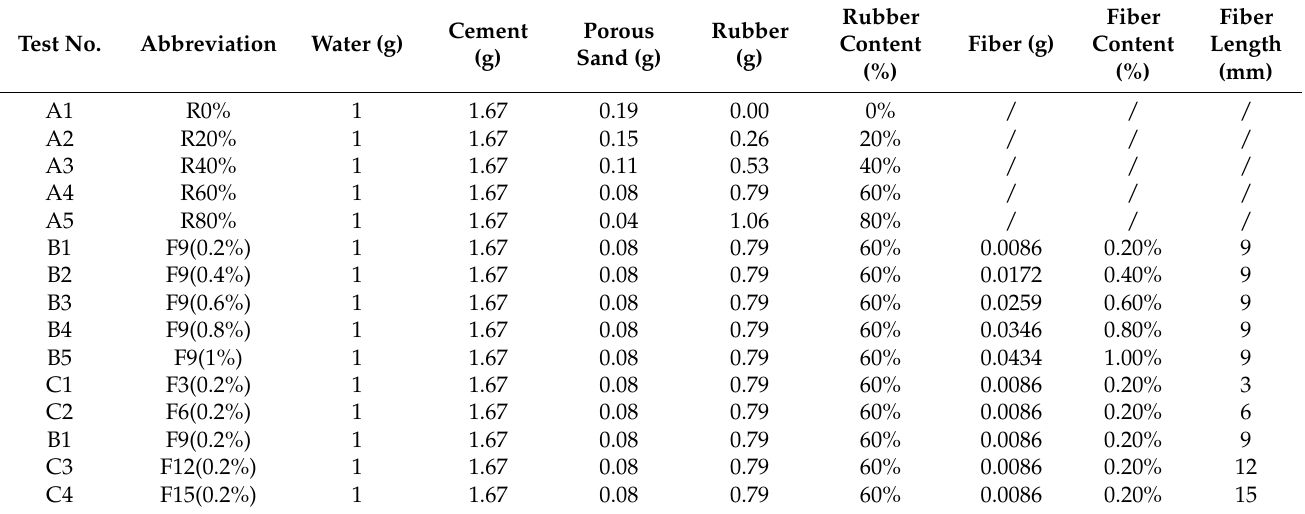
Table 4. Mixing ratios in terms of mass of each test